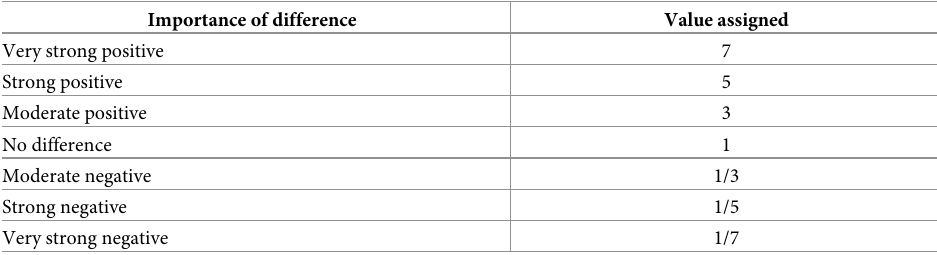
Table 1. Pairwise comparison ranking